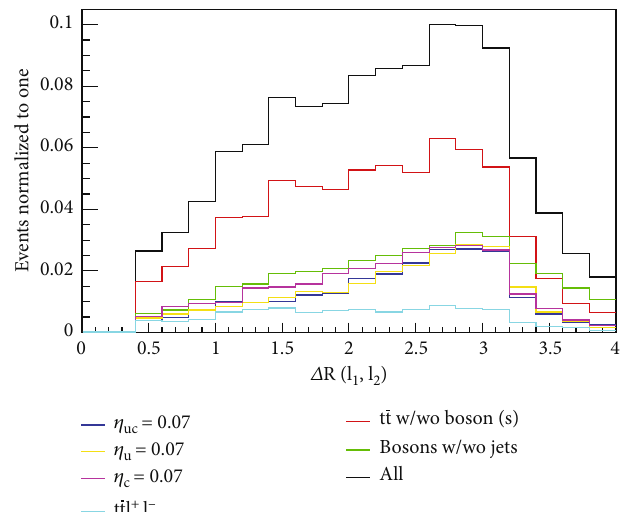
Þ distribution between two leptons. The Δ R variable in leptons is very crucial for discrimination, as it is in jets, but their Figure 18: Δ R ð l + , l + 1 2 behavior is much looser in comparison to jets due to additional energy-momentum conservation constraints from the decay of the W